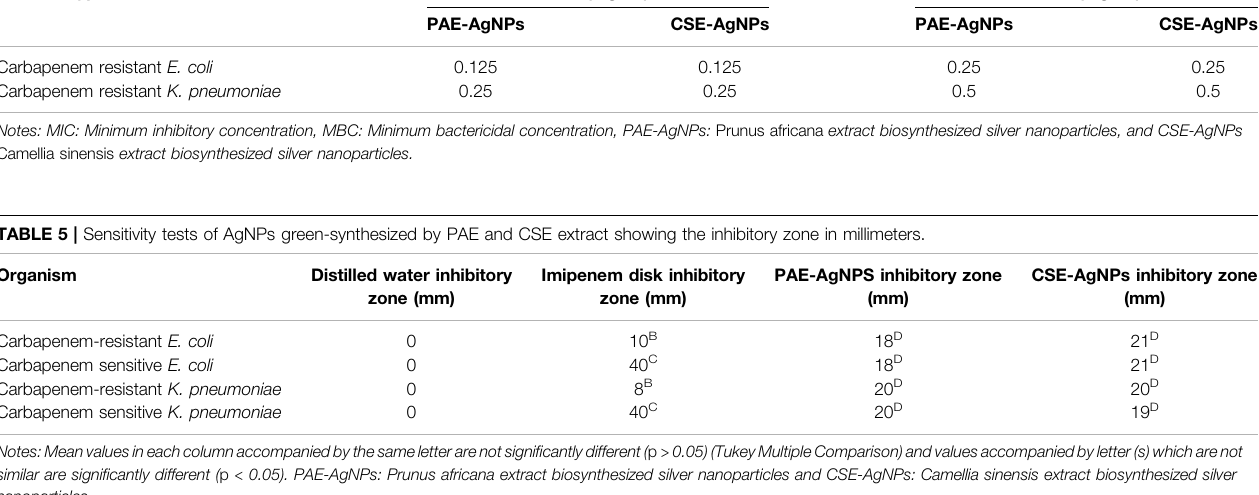
TABLE 4 | MIC and MBC values of AgNPs against Carbapenem-resistant E. coli and K. pneumoniae . Bacteria type MIC (mg/ml) MBC (mg/ml) PAE-AgNPs CSE-AgNPs Carbapenem resistant E. coli